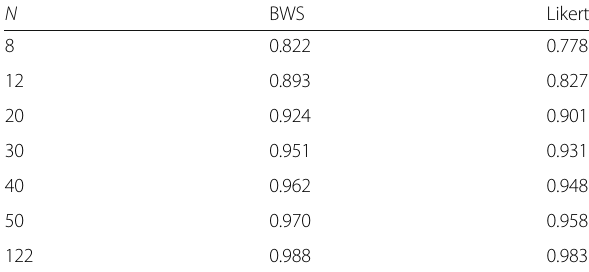
Table 3 Mean Cronbach ’ s alpha calculated from 50 random samples of size N from each of the BWS and Likert conditions. Higher values of alpha indicate increased reliability for the face-level scores in that condition. BWS best-worst